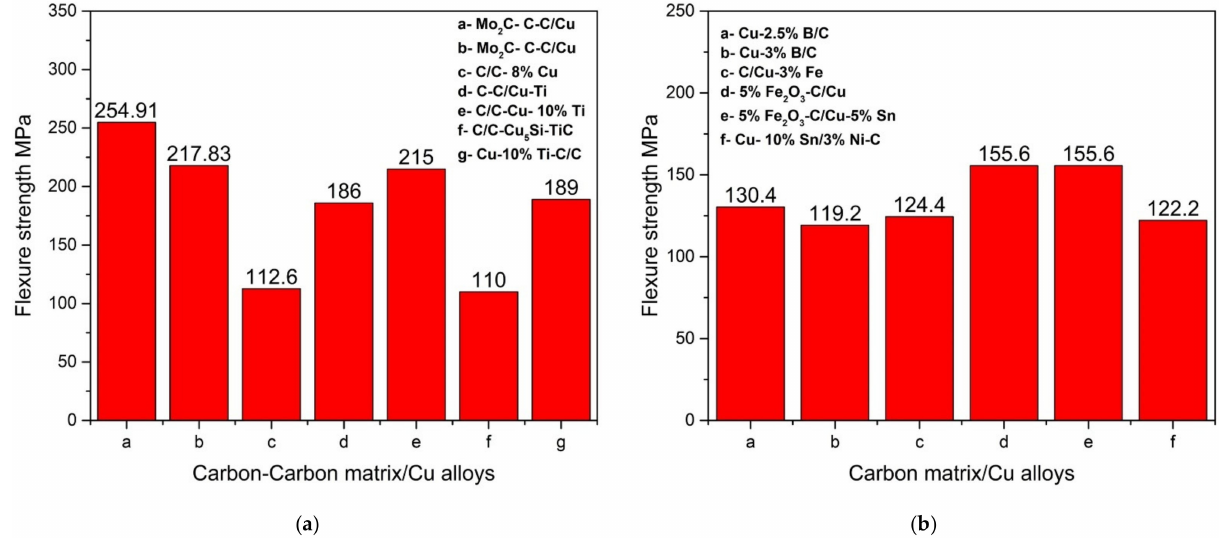
Figure 5. ( a ) Flexural strength of C/C matrix-Cu composites (a: [44]; b: [43]; c: [55]; d: [38]; e: [39]; f: [45]; g: [40]); ( b ) carbon matrix/Cu composites (a: [47]; b: [48]; c: [49]; d: [52]; e: [53]; f: